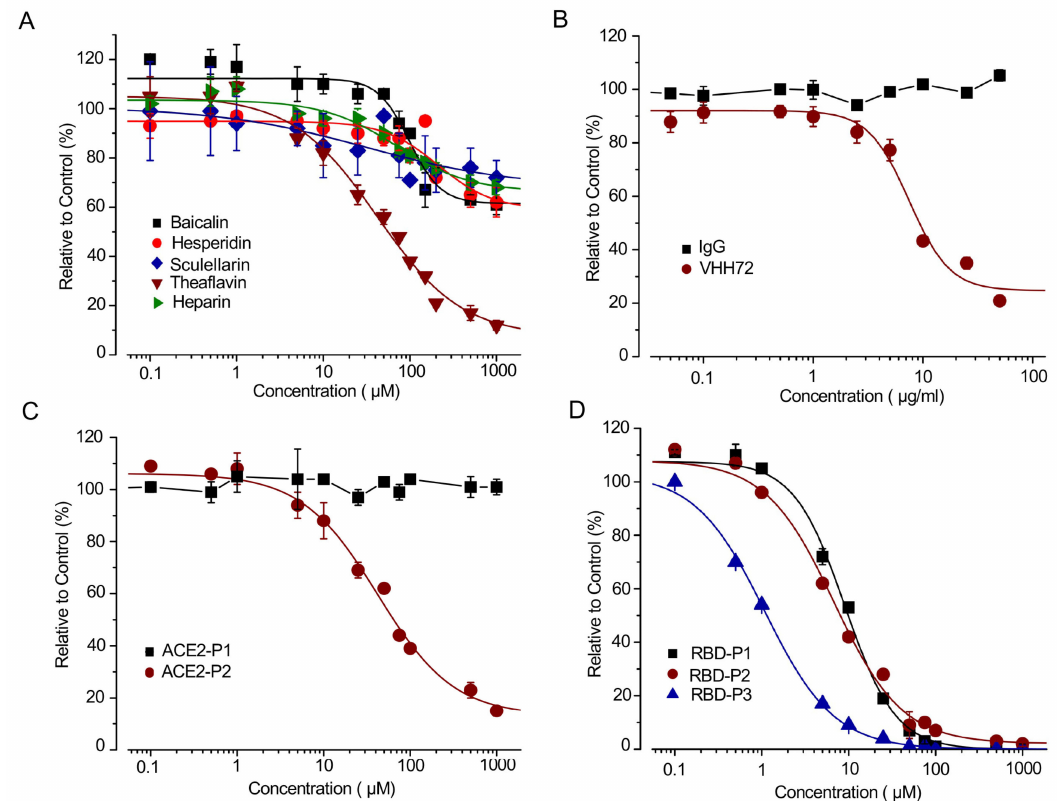
Figure 3. Dose-dependent effect of SMs, antibody and peptides on SRAE2-BS activity. ( A – C ) Increasing concentrations of SMs ( A ), IgG (control) or VHH72 anti-RBD antibody ( B ), or ACE2-P1-P2 peptides ( C ) were preincubated with RBD-Lg-His, and subsequently incubated with Sm-ACE2-His for 30 min, followed by measurement of RLU. ( D ) Increasing concentration of RBD-P1-P3 peptides were preincubated with Sm-ACE2-His, and subsequently incubated with RBD-Lg-His, followed by measure of RLU. The mean +/ − standard error (S.E.) of relative values (relative to control) of triplicate samples were calculated in comparison to samples without treatment